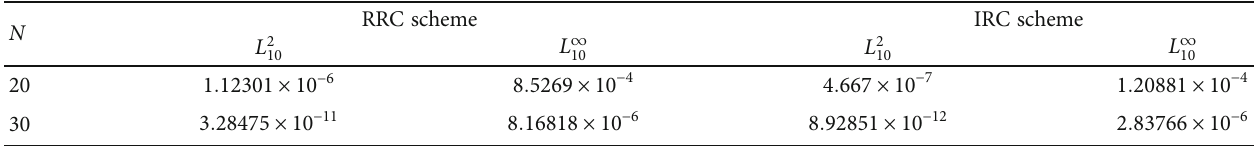
and L ∞ on interval x ∈ ½ 0, 10 (cid:2) for λ = − 1 . 10 10